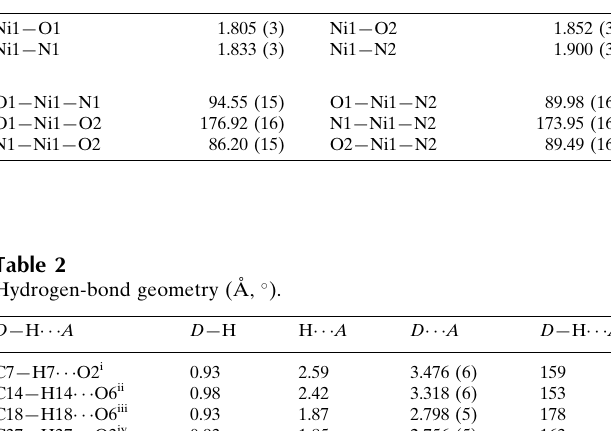
Selected geometric parameters (A˚ , (cid:5) ).